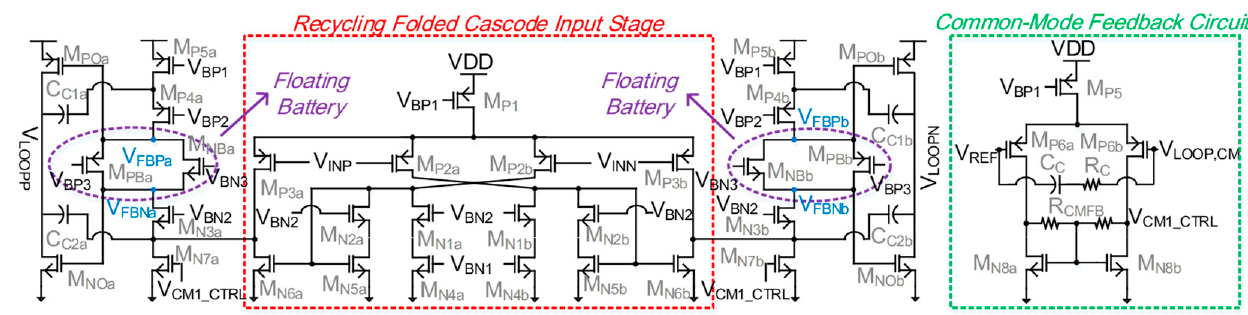
Figure 4. Schematic of the rail-to-rail output two-stage recycling folded cascode OPAMP including the CMFB circuit (bias circuit is omitted for simplicity).